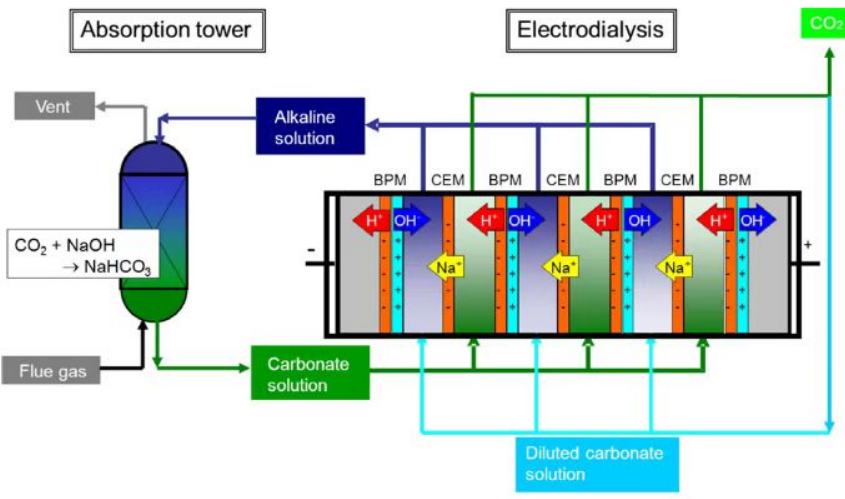
Figure 13. CO 2 absorption and recovery process [87].